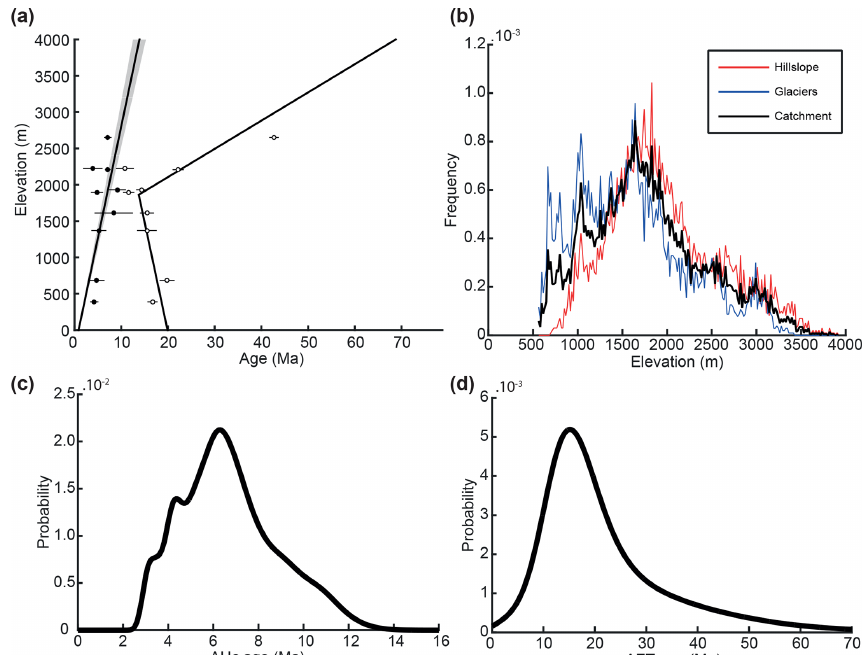
Figure 4. Synthetic bedrock thermochronological age distributions for the Tiedemann Glacier model. The age-elevation profile for the two thermochronological systems AHe and AFT (a) . Black and white circles represent the bedrock AHe and AFT ages from Ehlers et al. (2015) and Enkelmann and Ehlers (2015), respectively. Solid black lines are the best-fit solution for the data. Shaded areas for the AHe age-elevation show the 10% uncertainty considered for AHe ages. The catchment hypsometry frequency as well as glaciers and hillslope hypsometry frequencies are presented in (b) . The bedrock AHe distribution considering 10% relative uncertainties and bedrock AFT distribution with > 30% relative uncertainties are shown in (c) and (d) ,